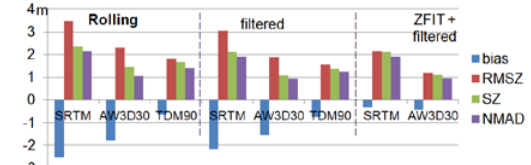
Figure 13. Accuracy results in open areas of test site